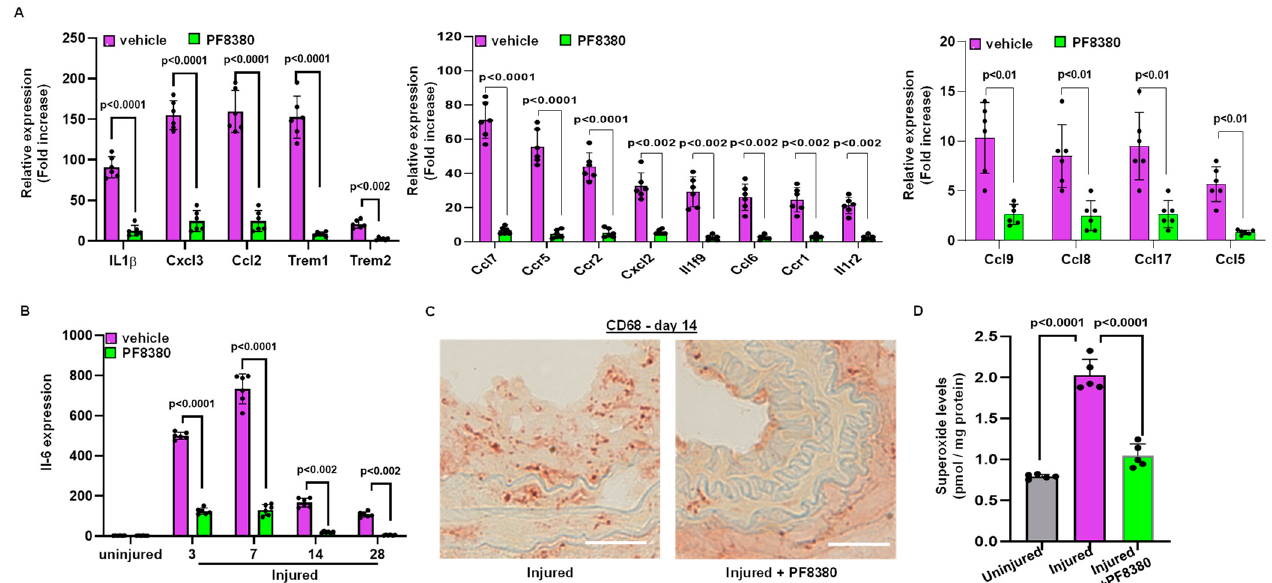
Figure 5. Treatment with the ATX inhibitor rescues mRNA encoding proteins associated with inflammation following injury. ( A ) Chemokine and cytokine mRNA expression was measured on day 3 with and without PF8380 treatment following injury. ( B ) Transcriptional mRNA expression levels of IL-6 with and without PF8380 treatment for different time points. ( C ) Representative sections of mouse carotid artery stained with CD68 antibody (C68-target for macrophages) with and without PF8380 treatment at 2 weeks after injury. Scale bar = 50 μ m. ( D ) Superoxide measured using high- performance liquid chromatography in uninjured, injured, and PF8380-treated mice at day 14. All values are mean ± SD ( n = 6) compared to the uninjured vessel using the Mann–Whitney U test.